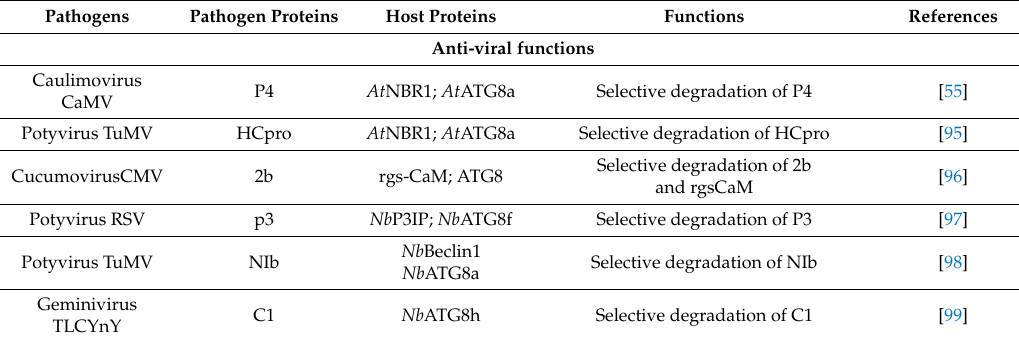
Table 2. Selective autophagy involved in plant–pathogen